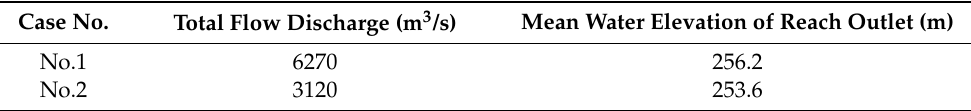
Figure 5. Terrain contours of the target reach after the spur dikes’ construction (the datum is the sea level, and the double spur dikes were built at the left bank around the middle position of the reach). Table 1. Flow conditions observed in field measurement for the two cases.